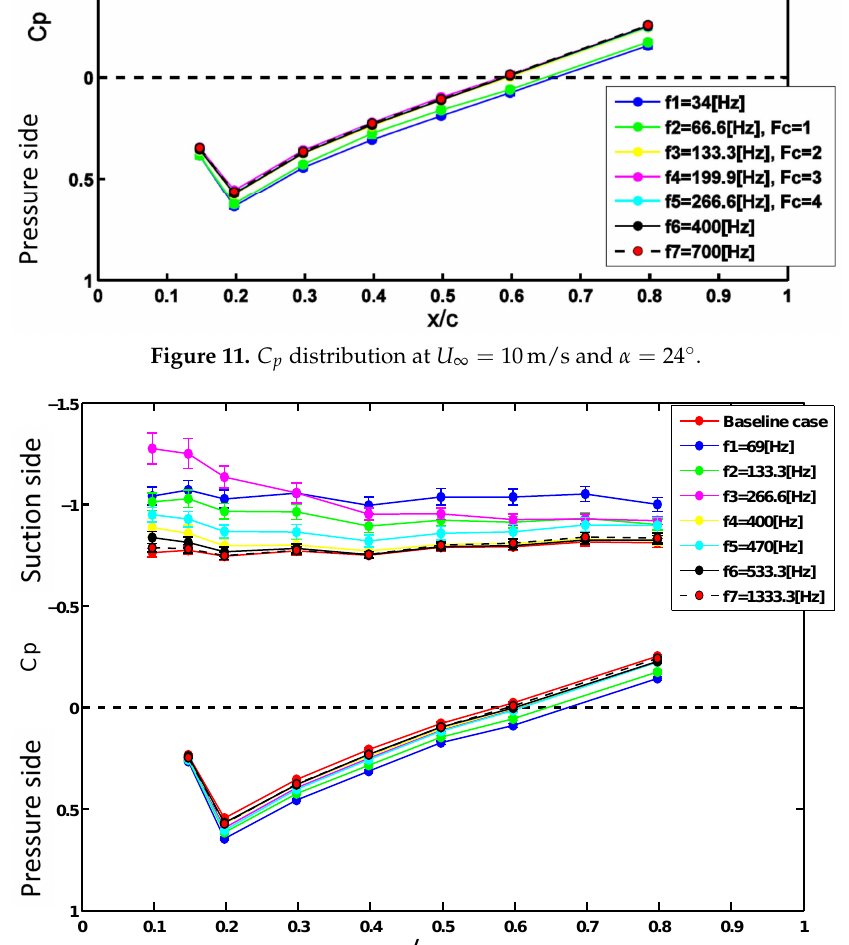
Figure 12. C p distribution at U ∞ = 20m/s and α = 24 ◦